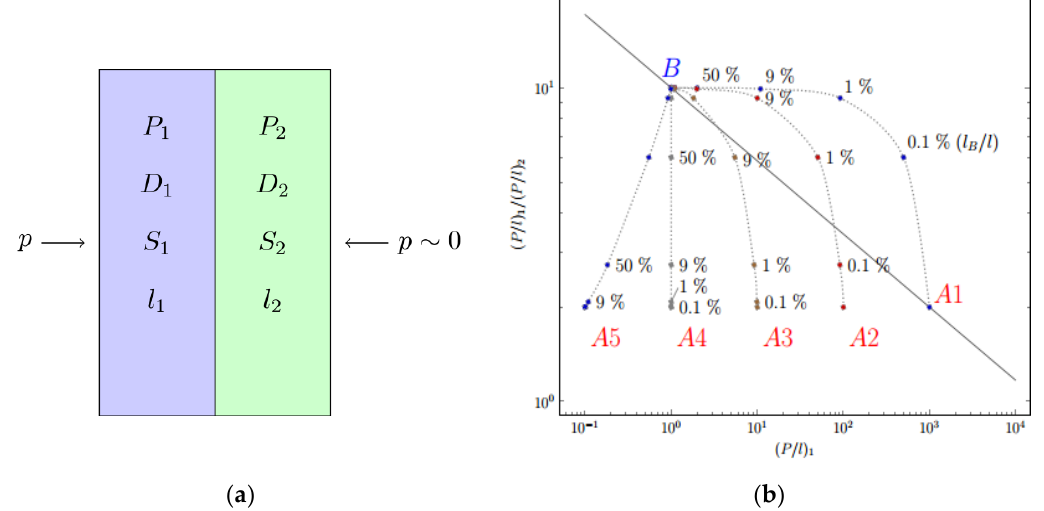
Figure 5. Scheme of two-layer laminate ( a ) and calculated permeability and separation parameters of a composite membrane based on initial polymer Ai and hypothetic perfluorinated polymer B ( b ).